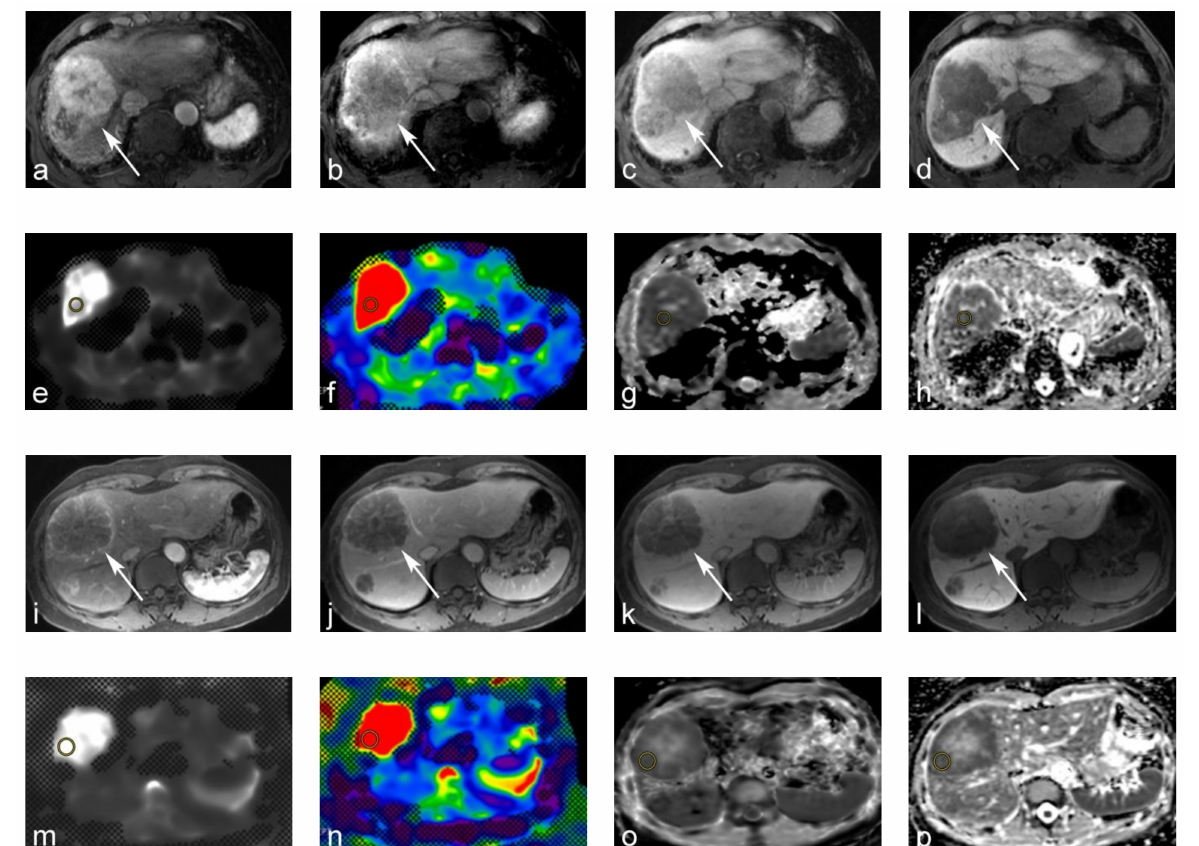
Figure 2. 69-year-old male with moderately differentiated hepatocellular carcinoma (HCC). ( a – d ) Gd-EOB-DTPA-enhanced magnetic resonance image (MRI): ( a ) tumors show arterial hyperenhancement on the arterial-phase. ( b , c ) Tumor shows a washout on the portal venous and transitional phase; ( d ) tumor shows a hypointensity on the hepatobiliary phase. ( e , f ) MR elastography (MRE). The tumor yielded a stiffness of 10.71 kPa on the MRE. ( g , h ) Apparent diffusion coefficient (ADC) maps. The tumor yielded a value of 0.63 × 10 − 3 mm 2 /s on the shifted ADC (sADC) map, and a value of 0.93 × 10 − 3 mm 2 /s on the ADC map. 60-year-old male with metastatic hepatic cancer from colorectal cancer. ( i – l ) Gd-EOB-DTPA-enhanced MRI. ( i , j ) Tumor showed rim-like enhancements on the arterial and portal venous phase. ( k , l ) The tumor was hypointense on the transitional and hepatobiliary phases. ( m , n ) MRE. The tumor yielded a stiffness of 15.59 kPa on MRE. ( o , p ) ADC maps. The tumor also yielded an sADC value of 0.72 × 10 − 3 mm 2 /s on the sADC map, and 0.86 × 10 − 3 mm 2 /s on the ADC